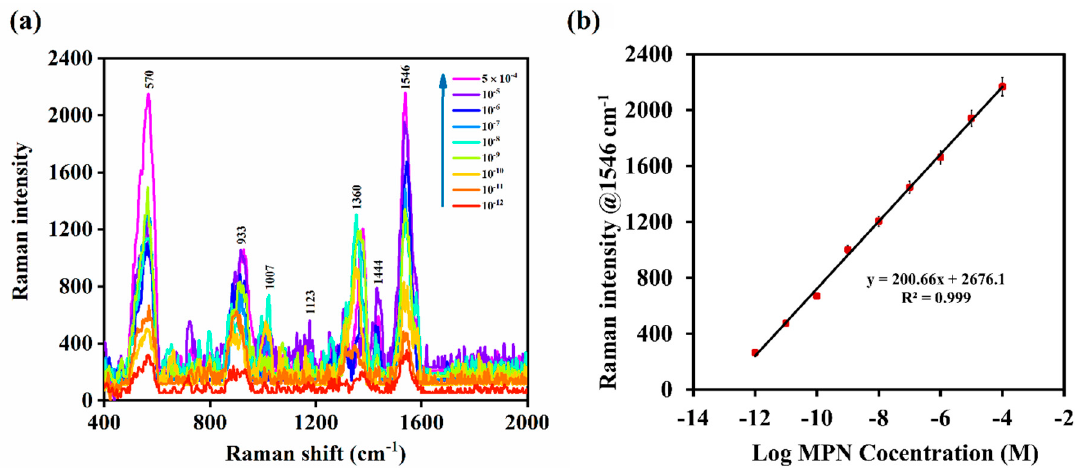
Figure 3. ( a ) Trend of SERS signal intensity of MPN in aqueous solution (concentration range; 5 × 10 − 4 M–1 × 10 − 12 M); ( b ) SERS calibration plot of MPN within the same concentration